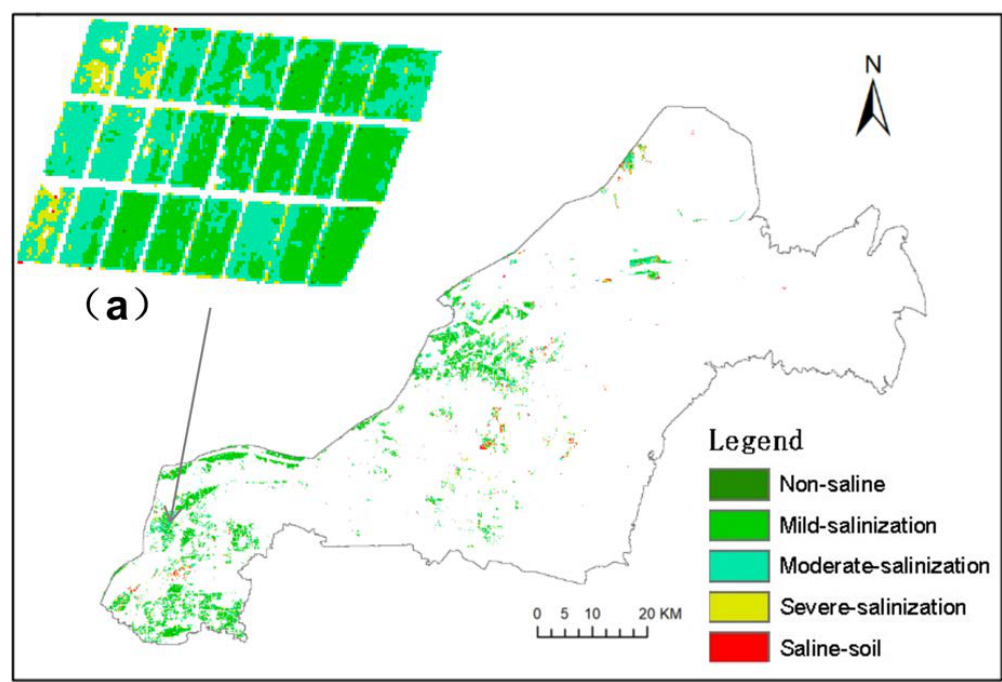
Figure 6. Inversion results based on “Satellite-UAV-Ground”, and (a) is a partial enlarged view.